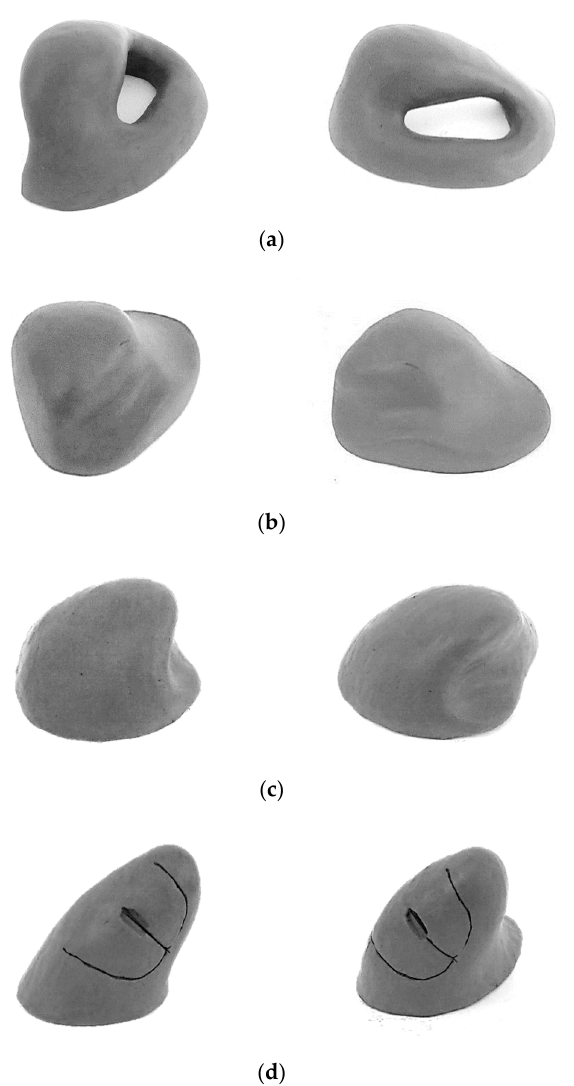
Figure 2. Concept generated. ( a ) pg concept; ( b ) pt concept; ( c ) ch concept; ( d ) ci concept.